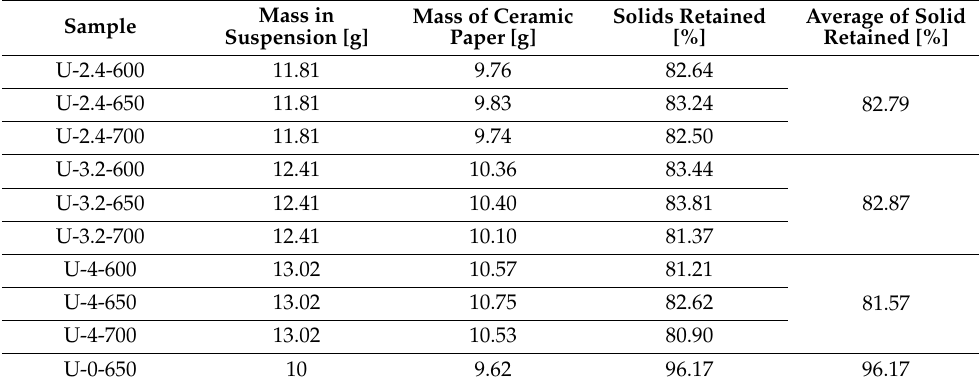
Table 2. Retention of inorganic solids in the elaboration of ceramic